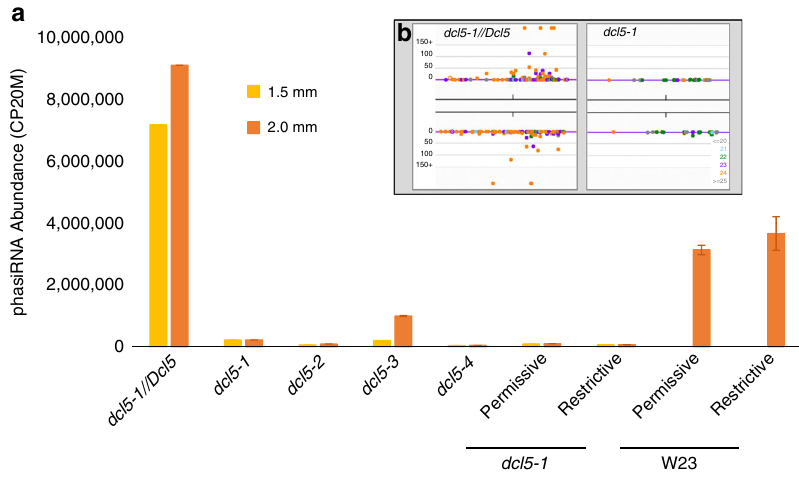
Fig. 3 Near absence of 24-nt phasiRNAs in CRISPR-derived dcl5 mutant alleles. a Total 24-nt phasiRNAs from 176 24-PHAS loci are highly abundant in both 1.5 and 2.0 mm fertile heterozygous anthers, but abundance is reduced by >99% in dcl5-1, dcl5-2 , and dcl5-4 , and by >90% in dcl5-3 anthers. Altered temperature regimes do not restore 24-nt phasiRNA abundances in either fertile (permissive) or sterile (restrictive) dcl5-1 anthers (see main text). W23 inbred fertile anthers have similar 24-nt phasiRNA abundance under both temperature regimes. Error bars indicate standard error of the mean (s.e.m.). b , inset Representative 24-PHAS locus #12 (B73, v4; chr 1, 178454619bp) in a genome browser showing ~1.5 kbp with sRNAs in the fertile heterozygote (left) and dcl5-1 (right). Orange dots are individual 24-nt phasiRNAs; x -axis is genome position on the top or bottom strand, and the y -axis depicts abundance in each genotype. Other colored dots are as indicated in the key, lower